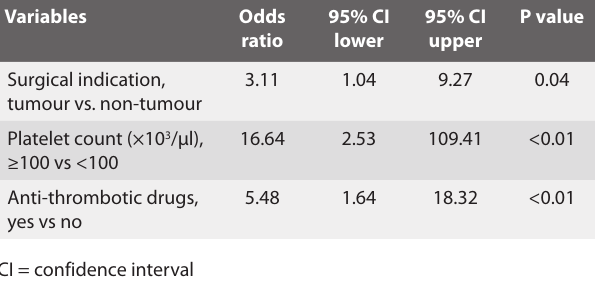
Table 3. Multivariate analysis of factors associated with postoperative